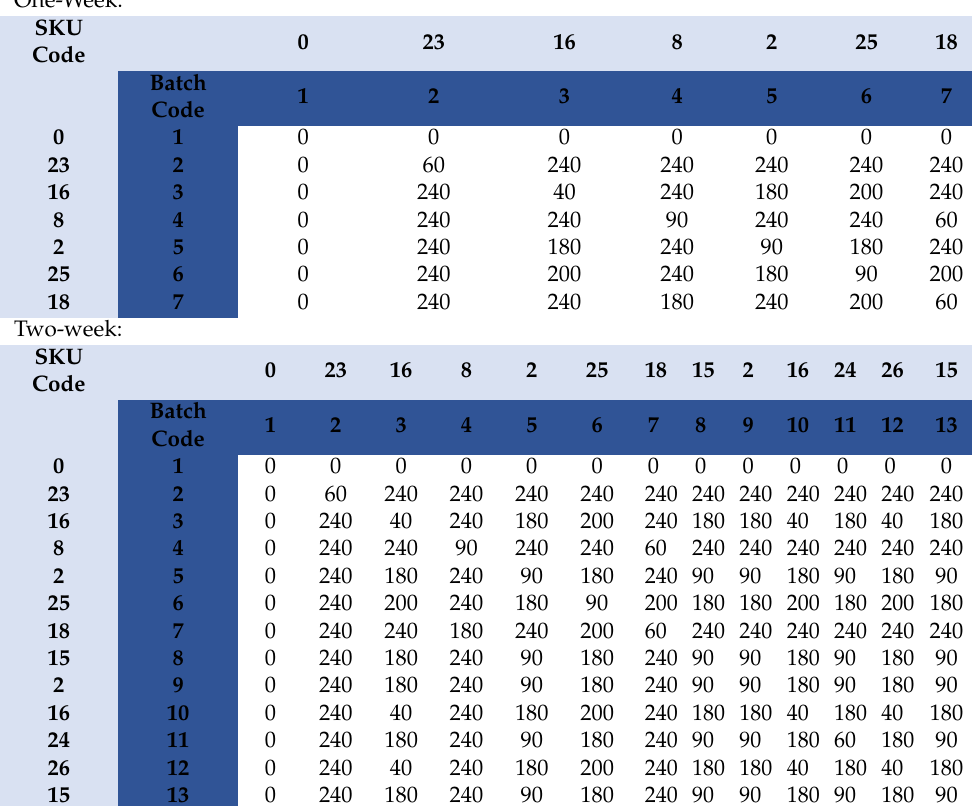
Table 3. Setup time matrix for one and two weeks, Machine 7, 13